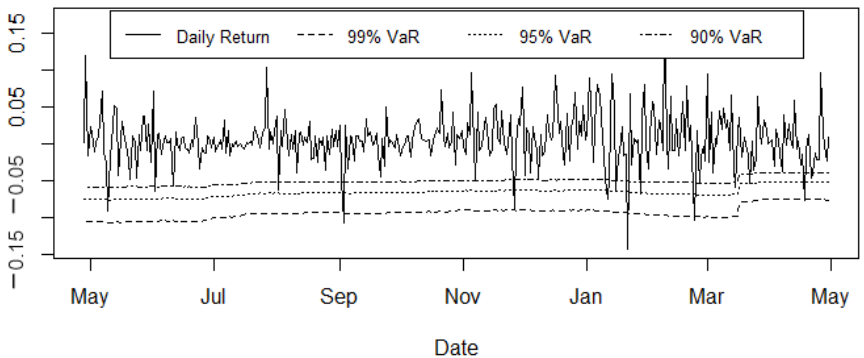
Figure 5. BTC daily return and Monte Carlo simulation VaR.